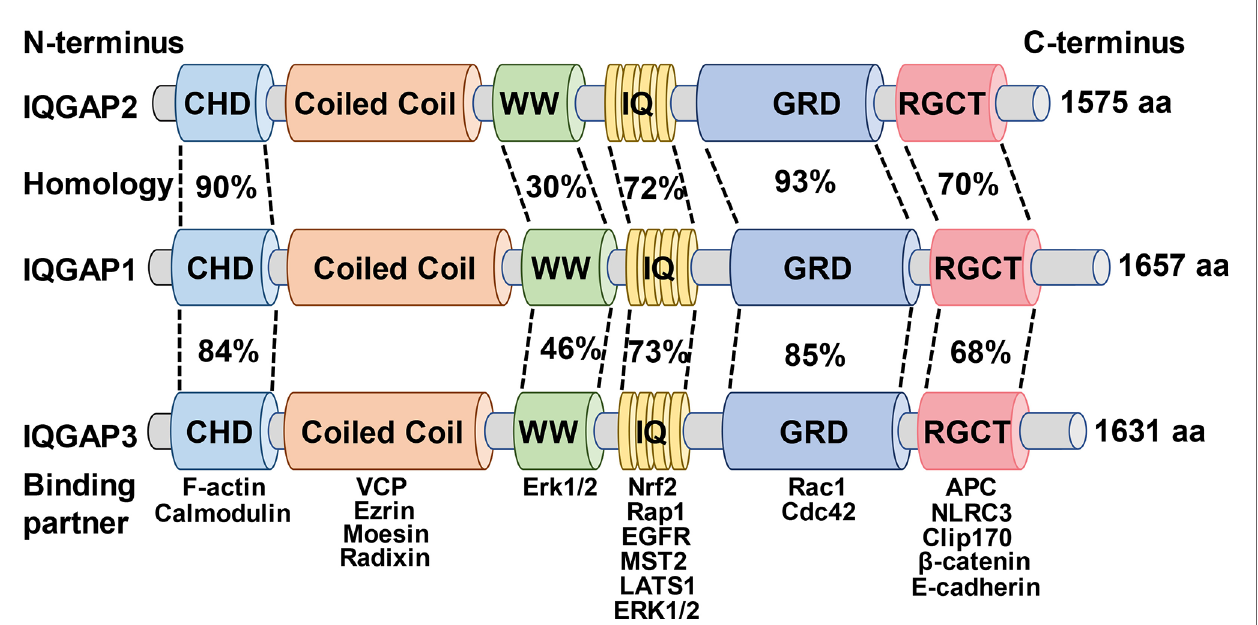
FIGURE 1 | Schematic illustration of the domain organization and amino acid homology of the IQGAPs family and the binding partners of the respective